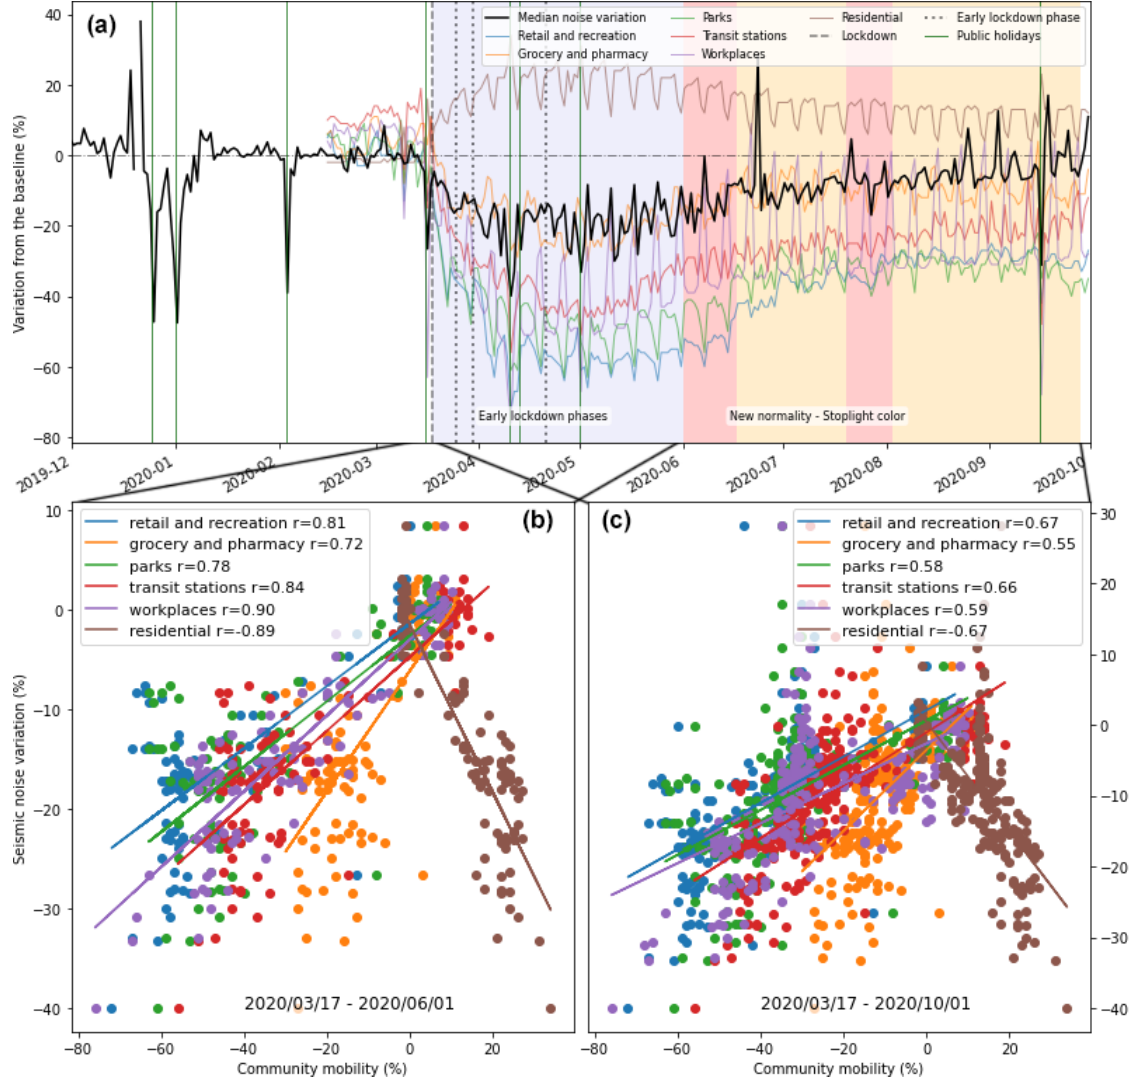
Figure 5. (a) Median of the variation of the seismic rms at all stations relative to the median of the corresponding day of the week during the baseline period of 13 January to 2 March and variation of the Google community mobility in six high-level categories. The public holidays are indicated with blue dashed lines, and the implementation of lockdown measures is indicated as the black dashed line. The purple span corresponds to the early lockdown phases, and the red and orange spans after 1 June are the corresponding stoplight color for the “new normality”. Cross-plot between the median seismic rms of the network and the Google community mobility in six high-level categories during the early lockdown phases (b) and including the new normality (c) . The Spearman correlation coefficients between the median seismic rms and each category of community mobility are provided in the